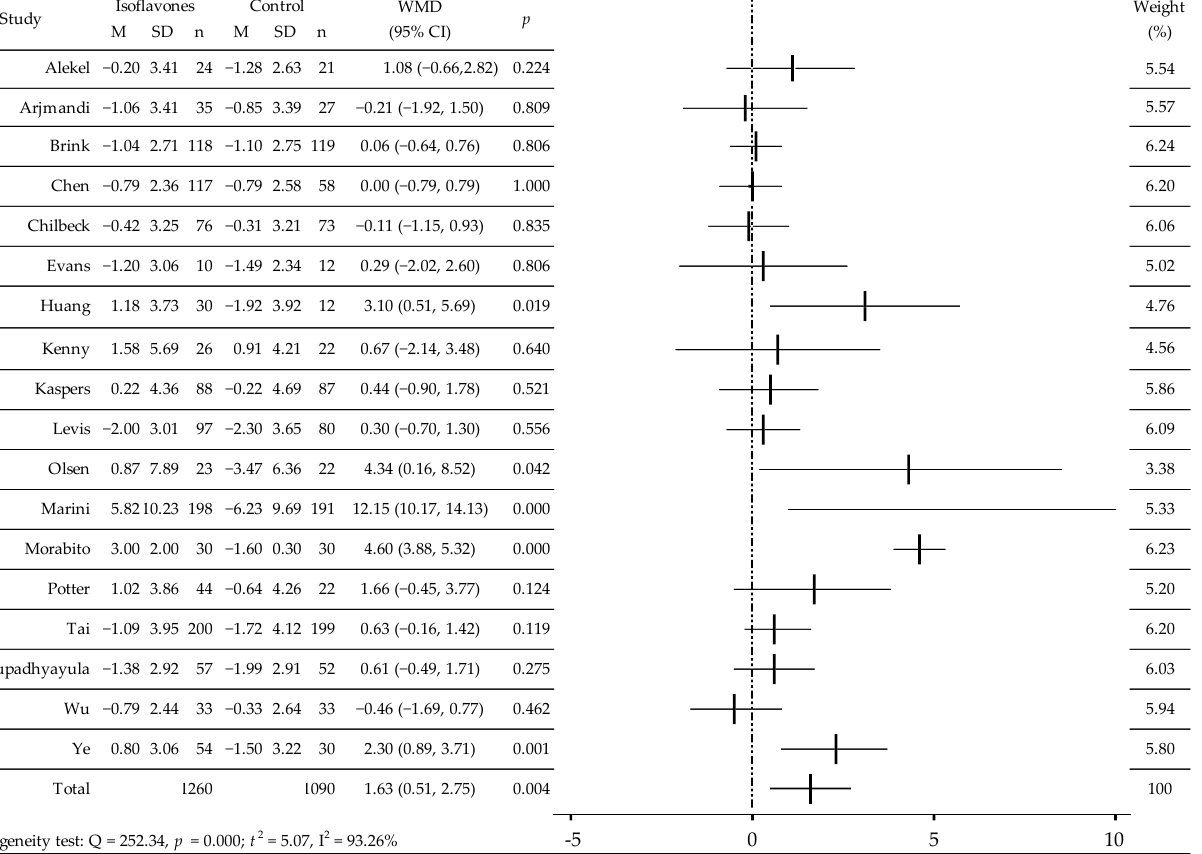
Figure 2. The effect of soy isoflavones on bone mineral density of the lumbar spine in postmenopausal women, compared with placebo [25–42]. M, mean change from baseline (%); SD, standard deviation; n, size of the study group; WMD, weighted average difference (%); CI, confidence interval; horizontal lines correspond to 95% CI (some of them go beyond the limits of the scale).